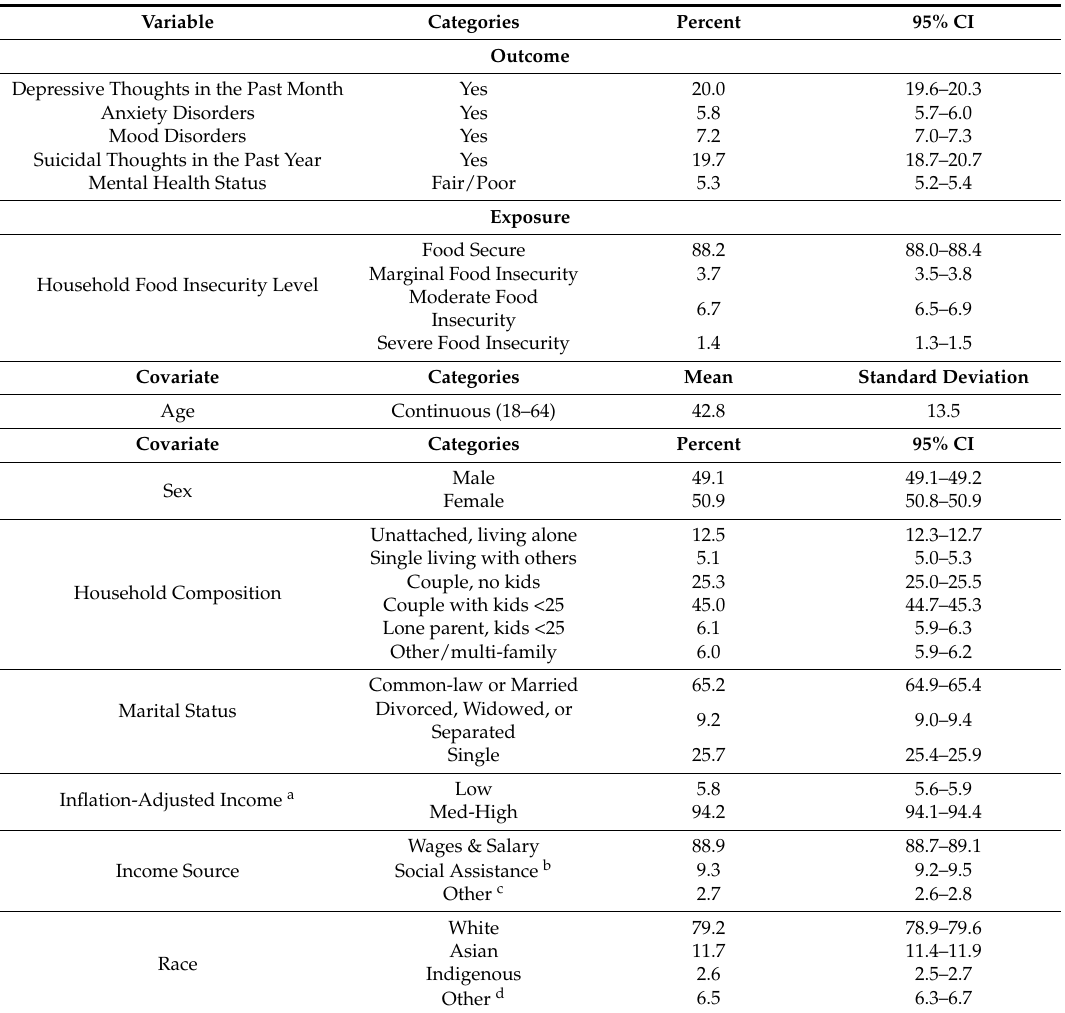
Table 1. Prevalence (%) and 95% confidence intervals (CI) of study variables (N = 302,683). CCHS—Canadian Community Health Survey. Variable Categories Percent 95% CI